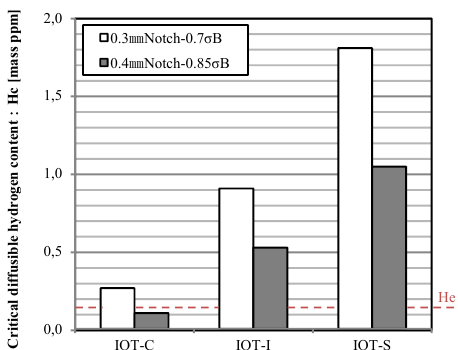
Figure 12. Results of external observation of CP350 utility poles exposed to bending for 4.4kN for 5